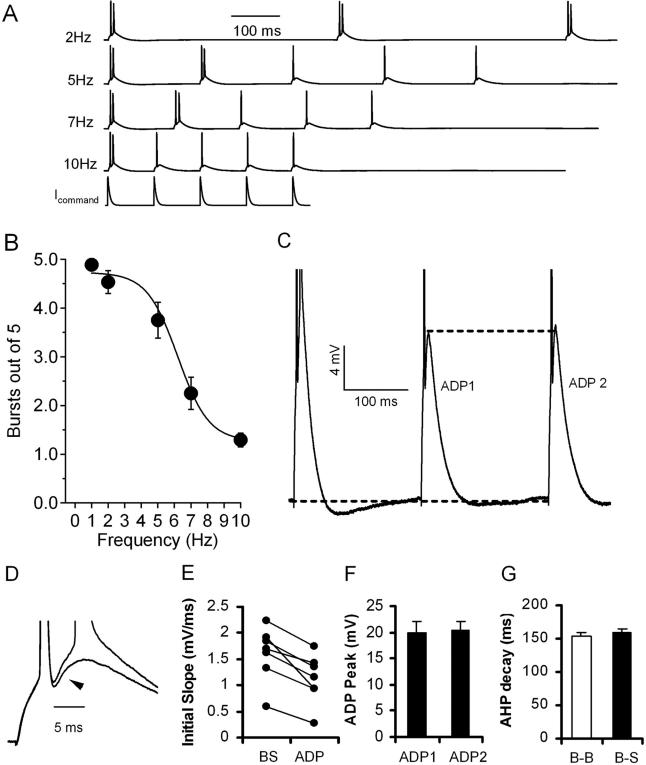
In Vitro Transition from Bursting to Single Spiking Output Is Frequency-Dependent(A) A representative cell shows the typical burst-to-single spike transition in response to current injections of five sEPSCs (τdecay = 6 ms) delivered at frequencies between 2 and 10 Hz. Note: Only the 10 Hz sEPSC is shown.(B) The average number of bursts in response to five sEPSC injections delivered at frequencies of 1–10 Hz (n = 17).(C) The representative trace shows the lack of a change between the ADP peaks (ADP1 versus ADP2) that follow a burst (5 Hz) and the complete decay of the AHP before the transition from bursting to single spiking.(D and E) A representative trace (D) and averaged data (E) show that the initial slope of the ADP is decreased during the transition from bursting to single spiking at 5 Hz (n = 7). The arrow in (D) points to the beginning of the ADP slope in an overlay of a burst before and after a transition to a single spike at 5 Hz.(F) The average peak of the ADP (in the absence of a second spike) does not change during a train (5 Hz; n = 4).(G) The average decay of the AHP (time for V
m to return to rest) is not different between two bursting events (B-B, n = 8) and transitions from bursting to single spike events (B-S, n = 8) at frequencies of 2–5 Hz.